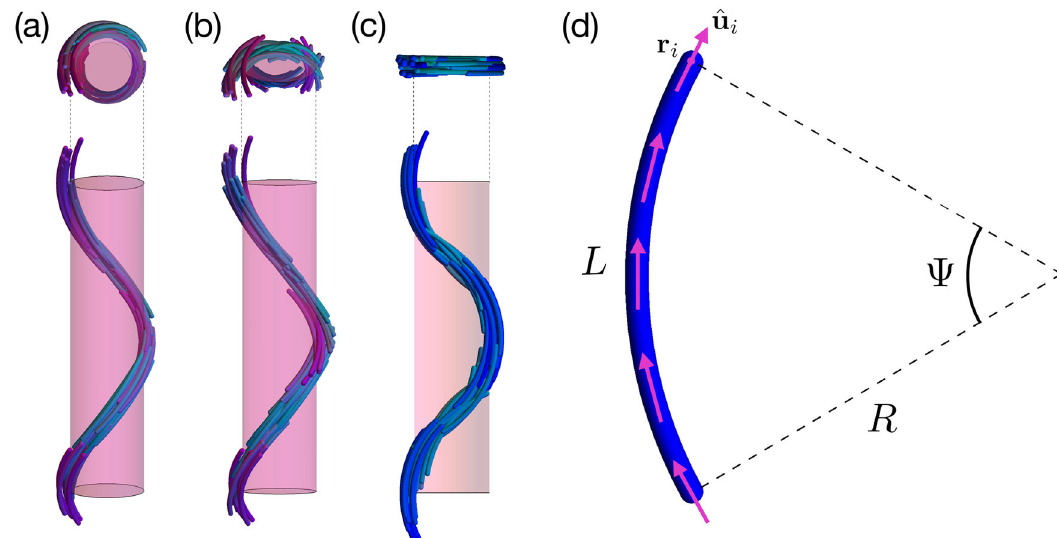
Fig. 1 Schematics of a twist-bend, twist-splay-bend, and splay-bend nematic phase of curved rods. a – c Side and top views of the spatial modulations of the particle orientations in ( a ) a chiral twist-bend nematic (N TB ) phase, b a chiral twist-splay-bend nematic (N TSB ) phase and ( c ) an achiral splay-bend nematic (N SB ) phase. d A hard curved spherocylinder consisting of a cylinder of length L and diameter D capped at both ends with a hemisphere of diameter D and bent with a radius of curvature R corresponding to an opening angle Ψ = L / R . In our generalized Maier – Saupe theory, this particle is modelled as a rigid chain of M segments with center-of-mass positions r i and orientations ^ u i tangent to the particle pro fi le for i ∈ 1, ⋯ , M , sketched by the (pink) arrows pointing upwards along the